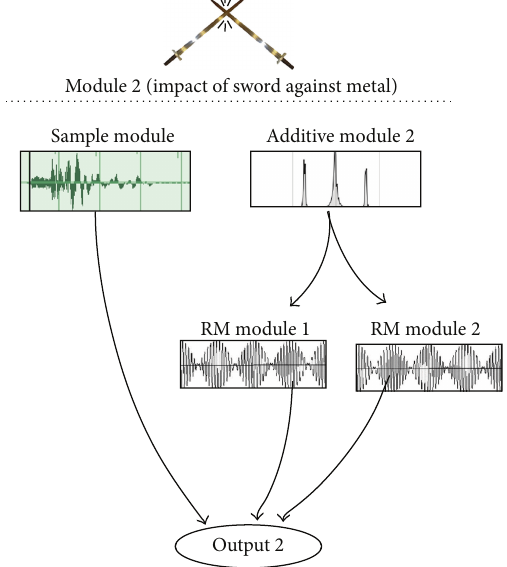
Figure 6: Illustration of the impact module 2 combining additive synthesis with sampling and ring modulation for the sword against metal collision.